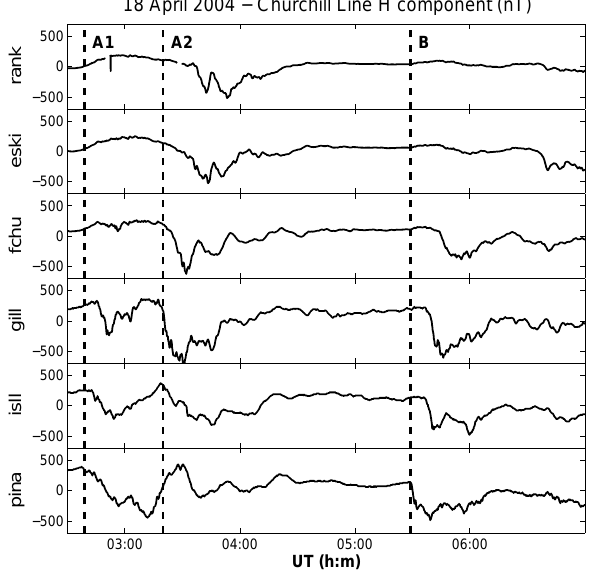
Fig. 7. Magnetograms from six magnetometers in the Churchill line displaying the H component for 02:30 UT to 07:00 UT on 18 April 2004. Daily averages of the measurements have been subtracted from the data to highlight variations in the magnetic observations.